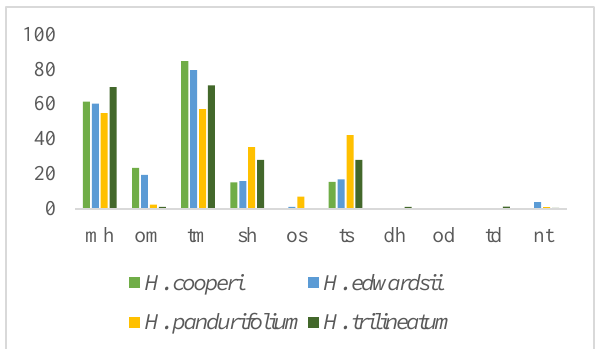
Figure 1. Variation of the class of compounds in the volatile organic compounds (VOCs) of the studied Helichrysum spp. mh: monoterpenes hydrocarbons; om: oxygenated monoterpenes; tm: total monoterpenes; sh: sesquiterpene hydrocarbons; os: oxygenated sesquiterpenes; ts: total sesquiterpenes; dh: diterpene hydrocarbons; od: oxygenated diterpenes; td: total diterpenes; nt: non-terpene derivatives. Table 2. Class of compounds in spontaneous emissions of the studied Helichysum spp. Chemical Classes H. cooperi Monoterpene Hydrocarbons (mh)